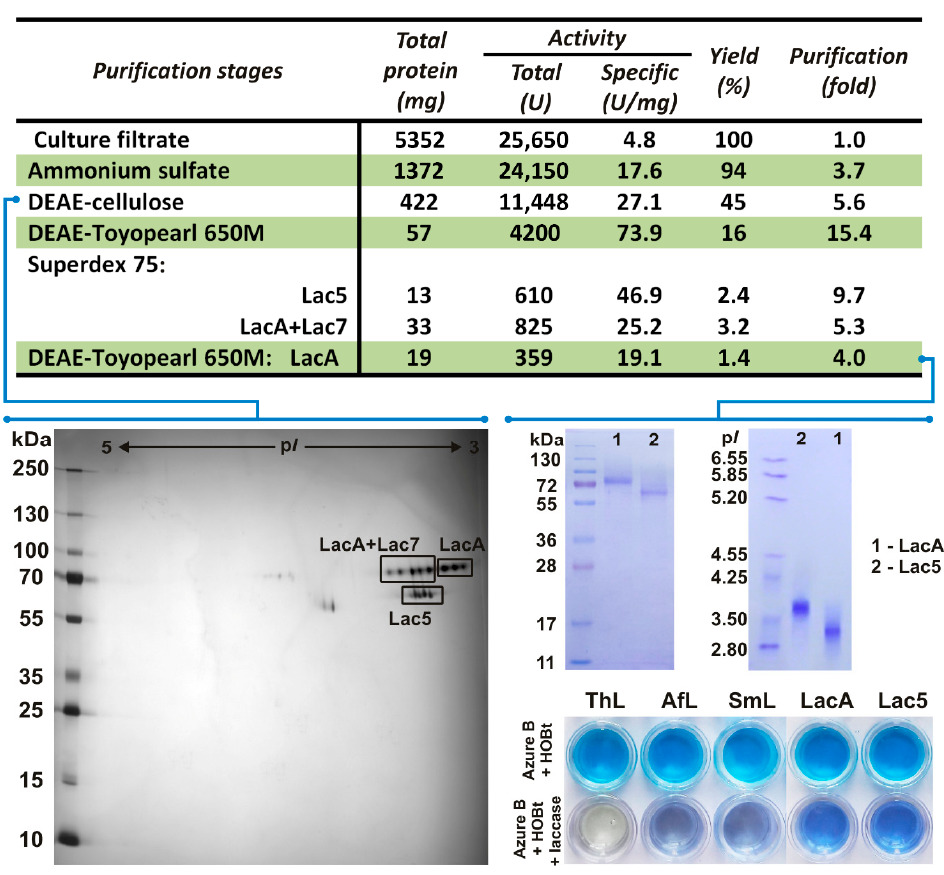
Figure 2. Purification scheme of P. lycii laccases and redox potential evaluation for purified Lac5 and LacA using the Azure B decolorization test. ThL— Trametes hirsuta laccase A ( E 0 T1 = 780